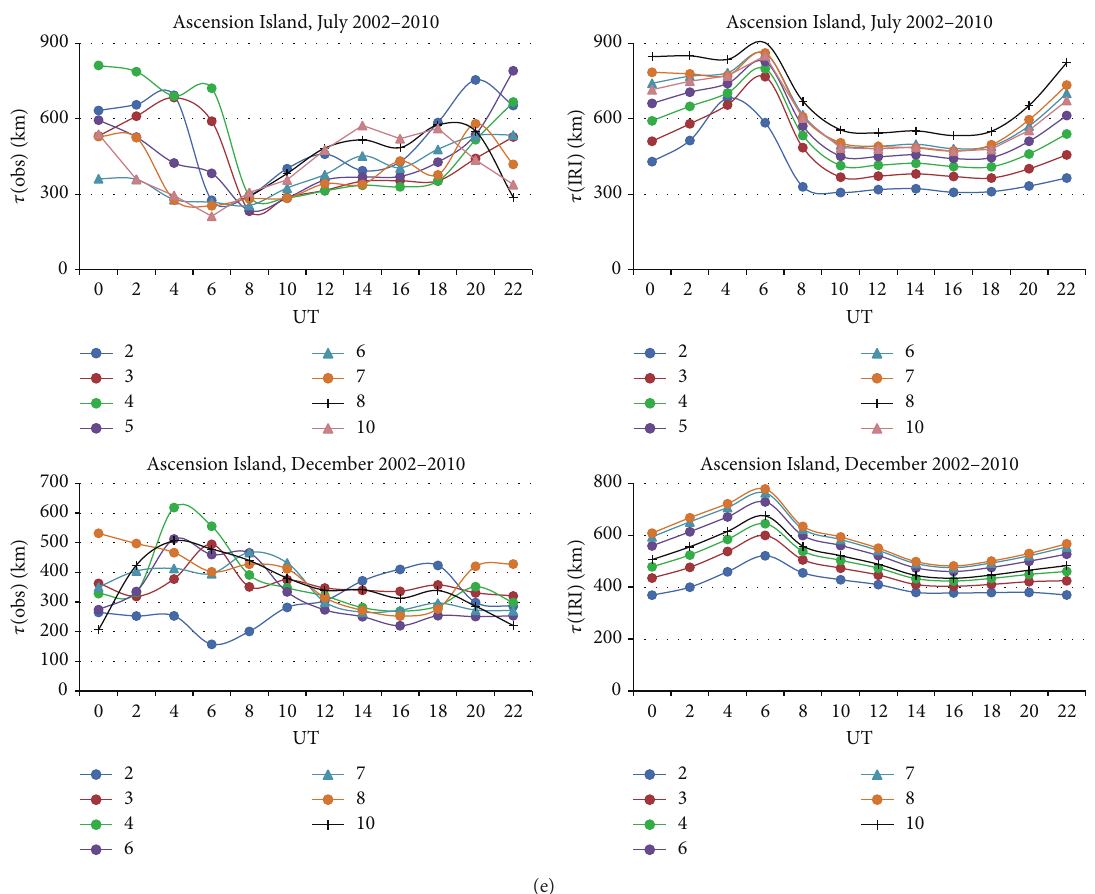
Figure 1: ( 1 ) Differences between model and experimental values of equivalent slab thicknesses for the middle-latitude station Juliusruh of the European region. (b) Differences between model and experimental values of equivalent slab thicknesses for the middle-latitude station Goosebay of the American region. (c) Differences between model and experimental values of equivalent slab thicknesses for the high-latitude station Thule. (d) Differences of model and experimental values of equivalent slab thicknesses for the low-latitude station Grahamstown. (e) Differences of model and experimental values of equivalent slab thicknesses for the equatorial station Ascension